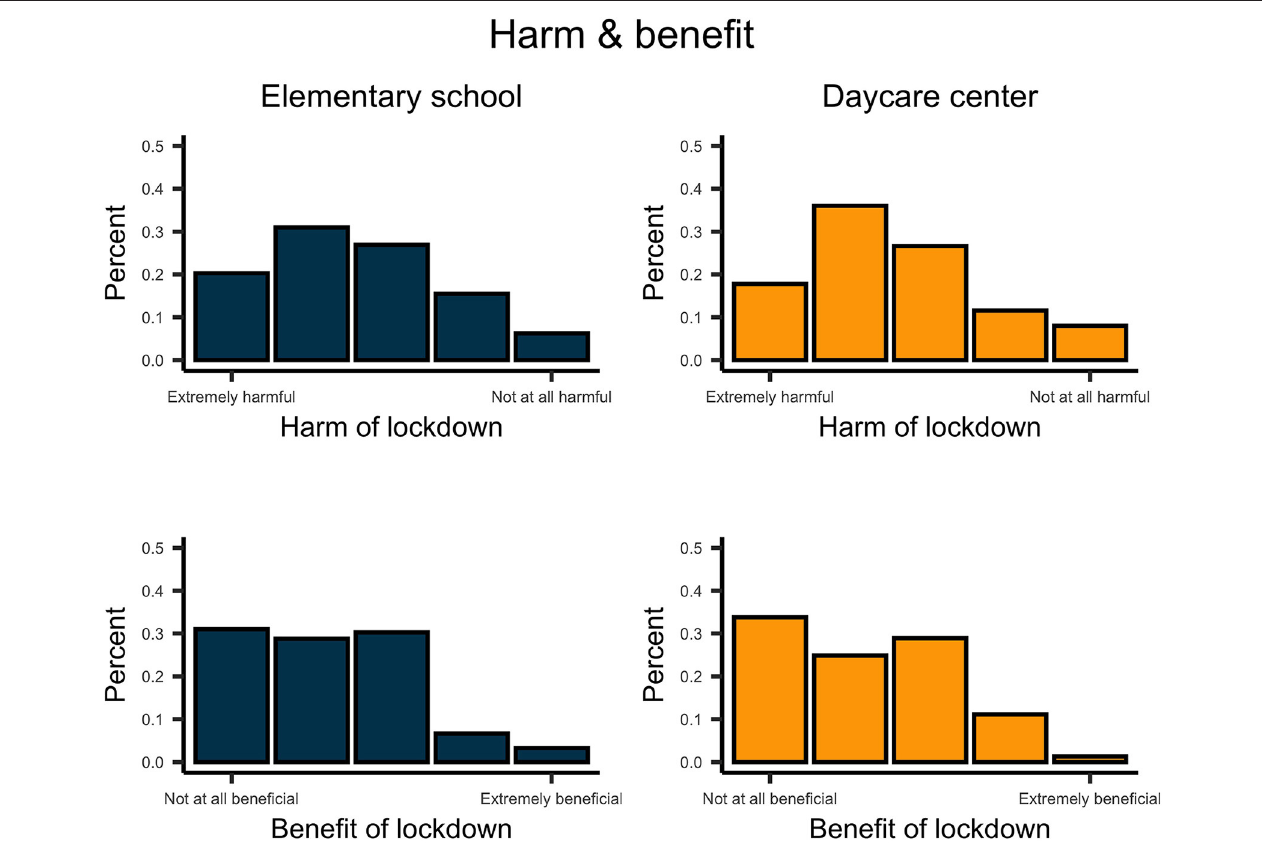
FIGURE 10 | Upper plots indicate how harmful parents perceive the lockdown for their school- and preschool-aged children. Lower plots indicate how beneficial parents perceive the lockdown for their school- and preschool-aged children.